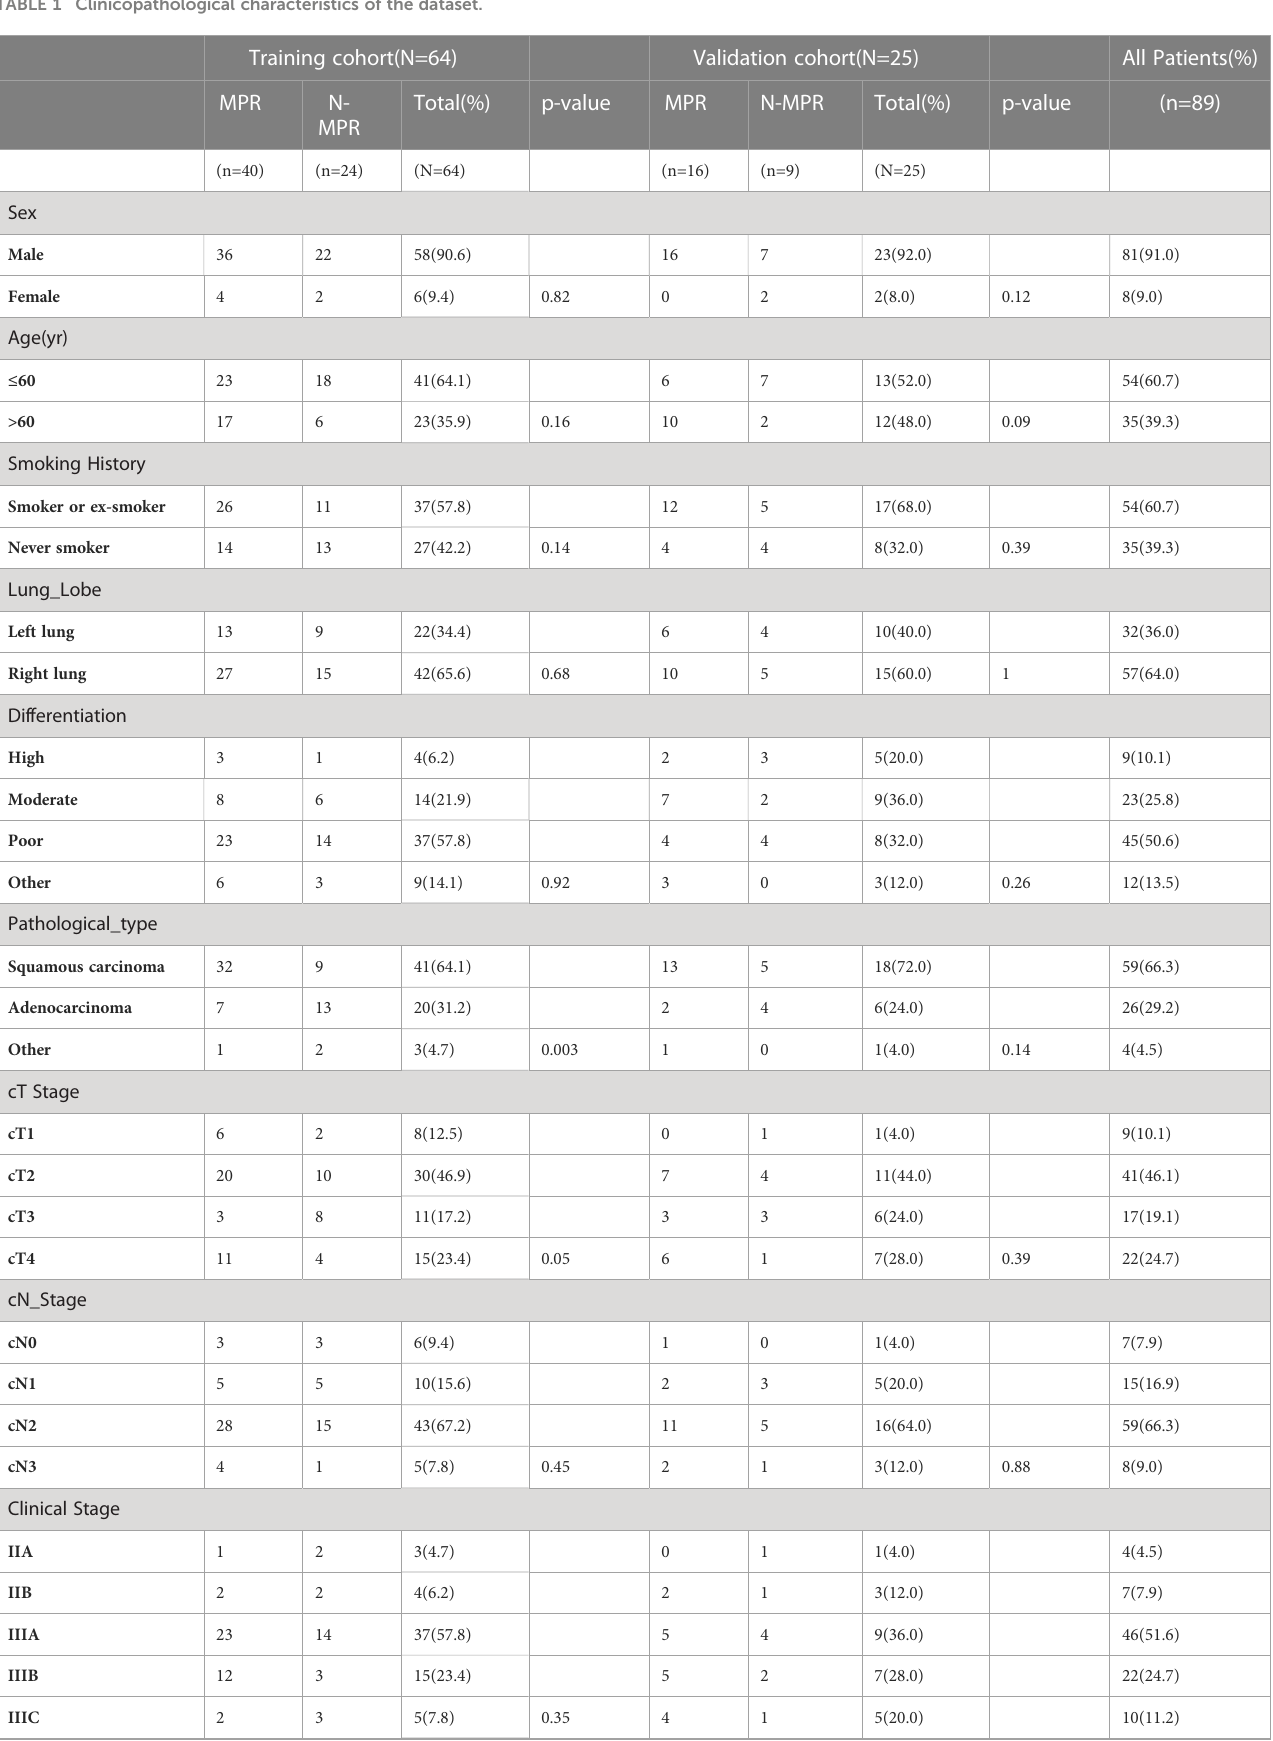
TABLE 1 Clinicopathological characteristics of the